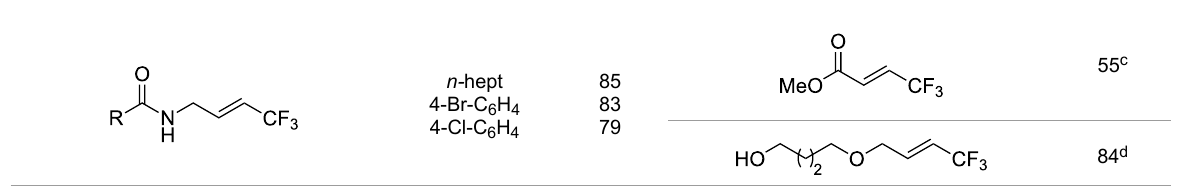
Table 32: Photoredox Ru-catalyzed trifluoromethylation of terminal and internal alkene C–H bonds with trifluoromethyl iodide [106]. (continued)